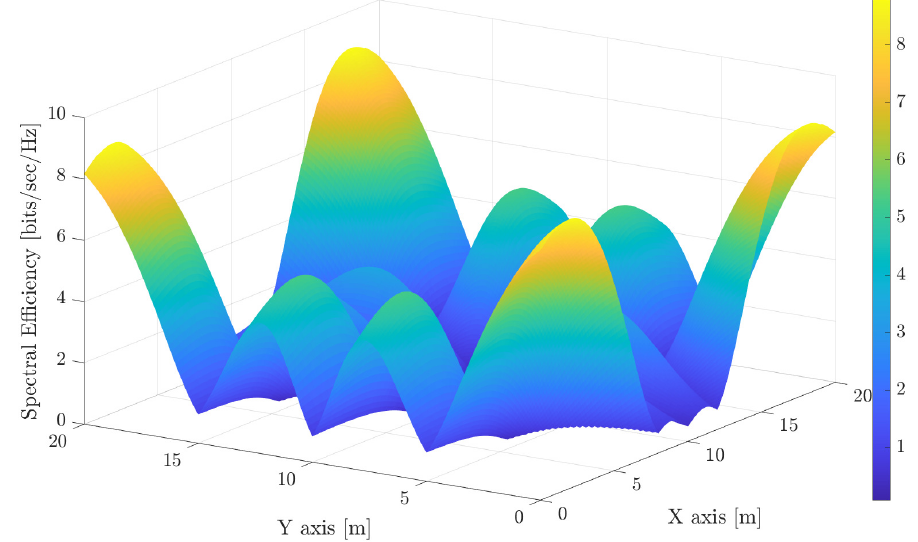
Figure 3. Spectral efficiency without cooperation among transmitters. Beam angle of 20 ◦